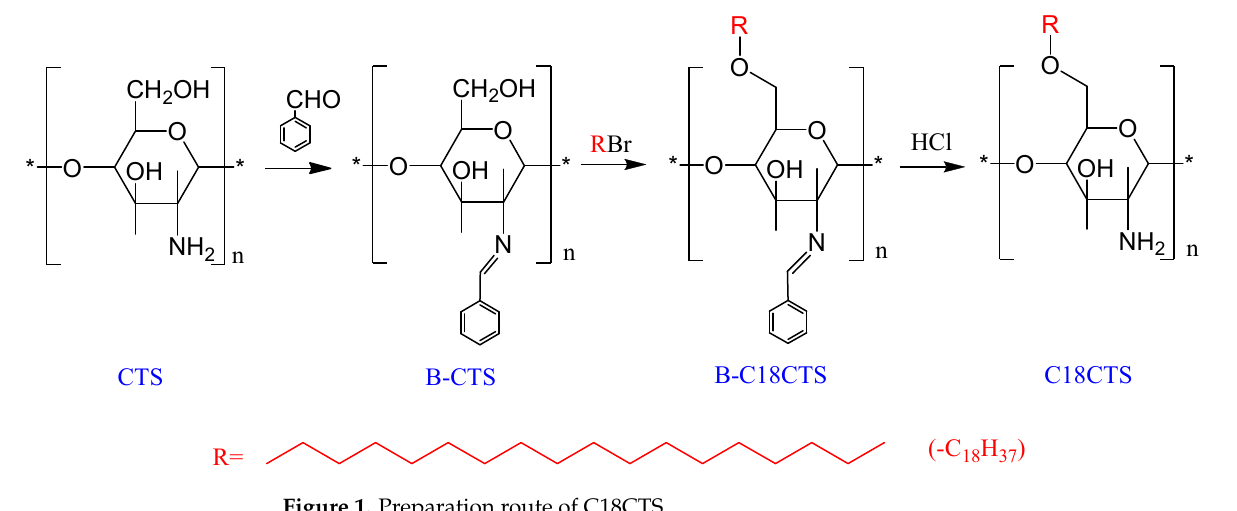
Figure 1. Preparation route of C18CTS.